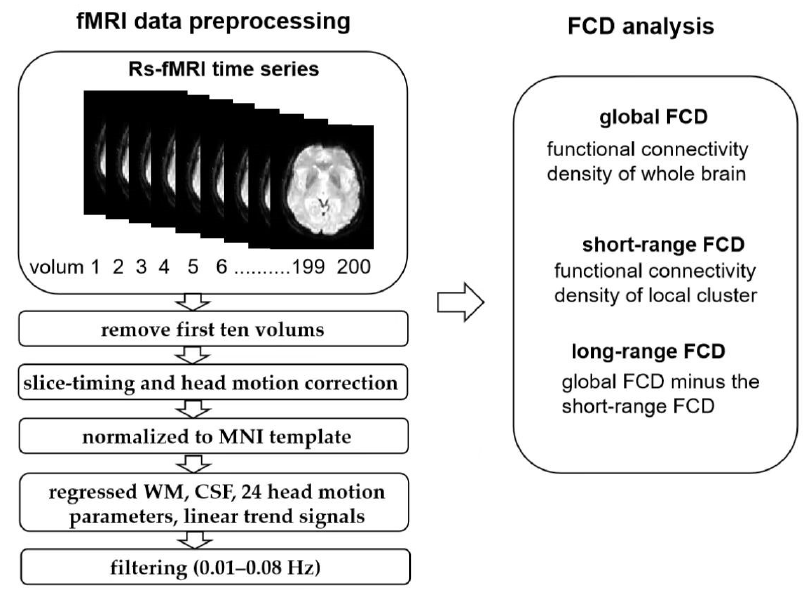
Figure 1. The fMRI data processing process in FCD.